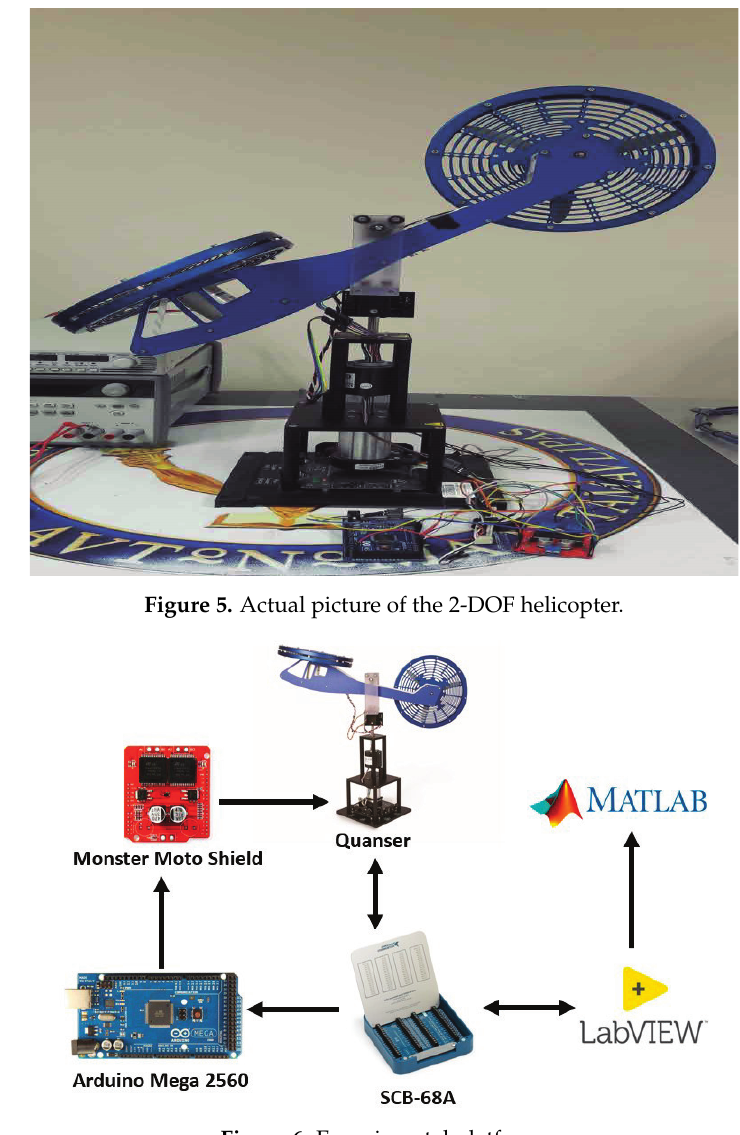
Figure 6. Experimental